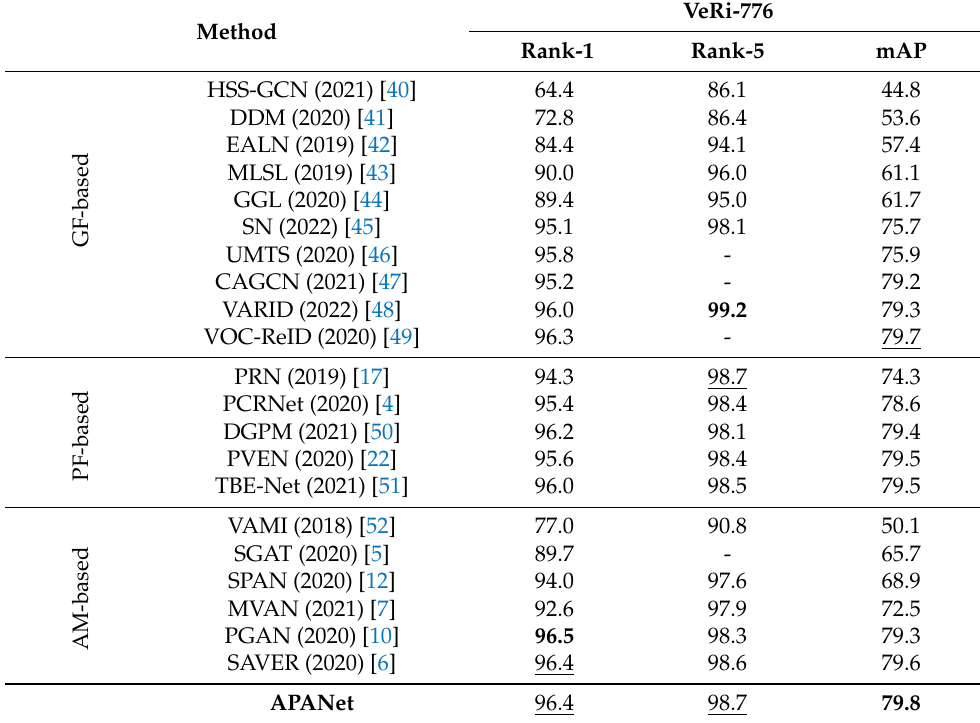
Table 7. Comparison results with state-of-the-art methods on VeRi-776 [3] in terms of rank and mAP. ‘-’ indicates the result is not reported. Note that the best performance is marked in bold and the second best accuracy is